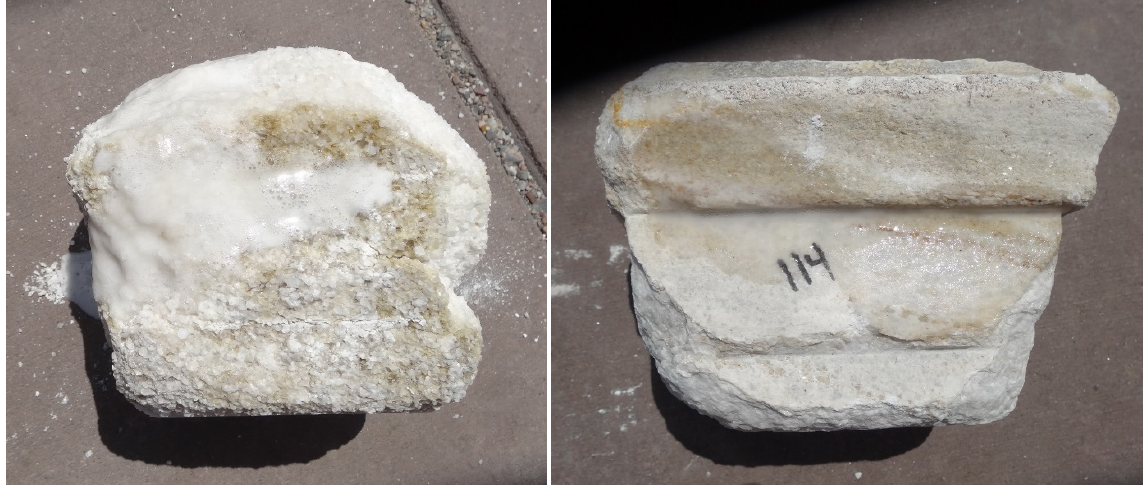
Figure 4: Field test using a diluted solution of hydrochloric acid to check for calcium carbonate on a Type 1 modillion (left) and a Type 4 modillion (right) that were removed from the north side of the capitol for Dutchman repairs.